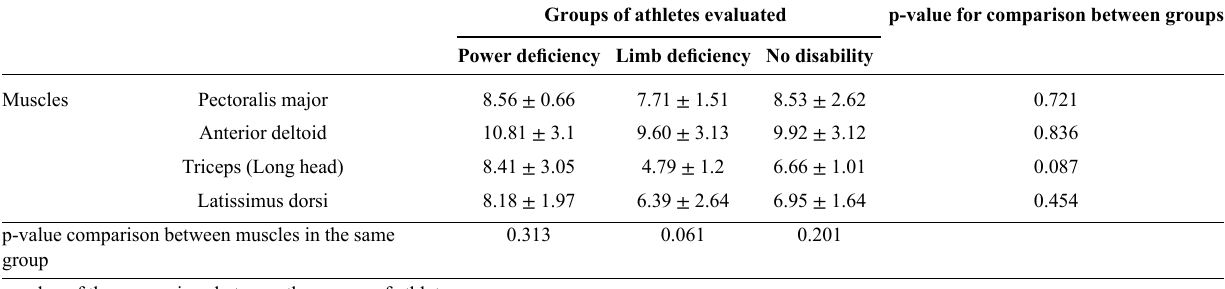
p-value of the comparison between the groups of athletes. Values are expressed as a percentage of the peak of the RMS presented during the execution of the simulated stroke. p-value established by analysis of variance with